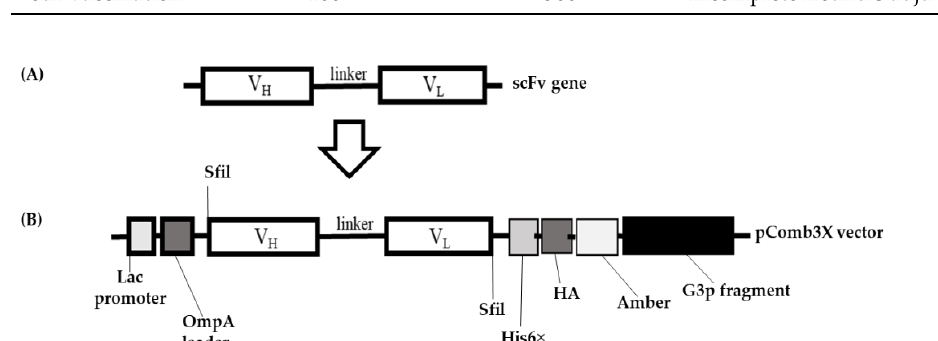
Figure 3. Schematic overview of single-chain variable fragment (scFv) gene cloning into the pComb3X plasmid. The arrangement of the V H and V L regions joined by a flexible linker representing the anti-CA16 scFv gene ( A ). The pComb3X gene constructs contained histidine (His6×) tag and hemagglutinin (HA) tag for detection and purification of recombinant scFv antibodies ( B ). The g3p fragment was included for the phage to display the scFv antibody protein on the surface of the viral particles.